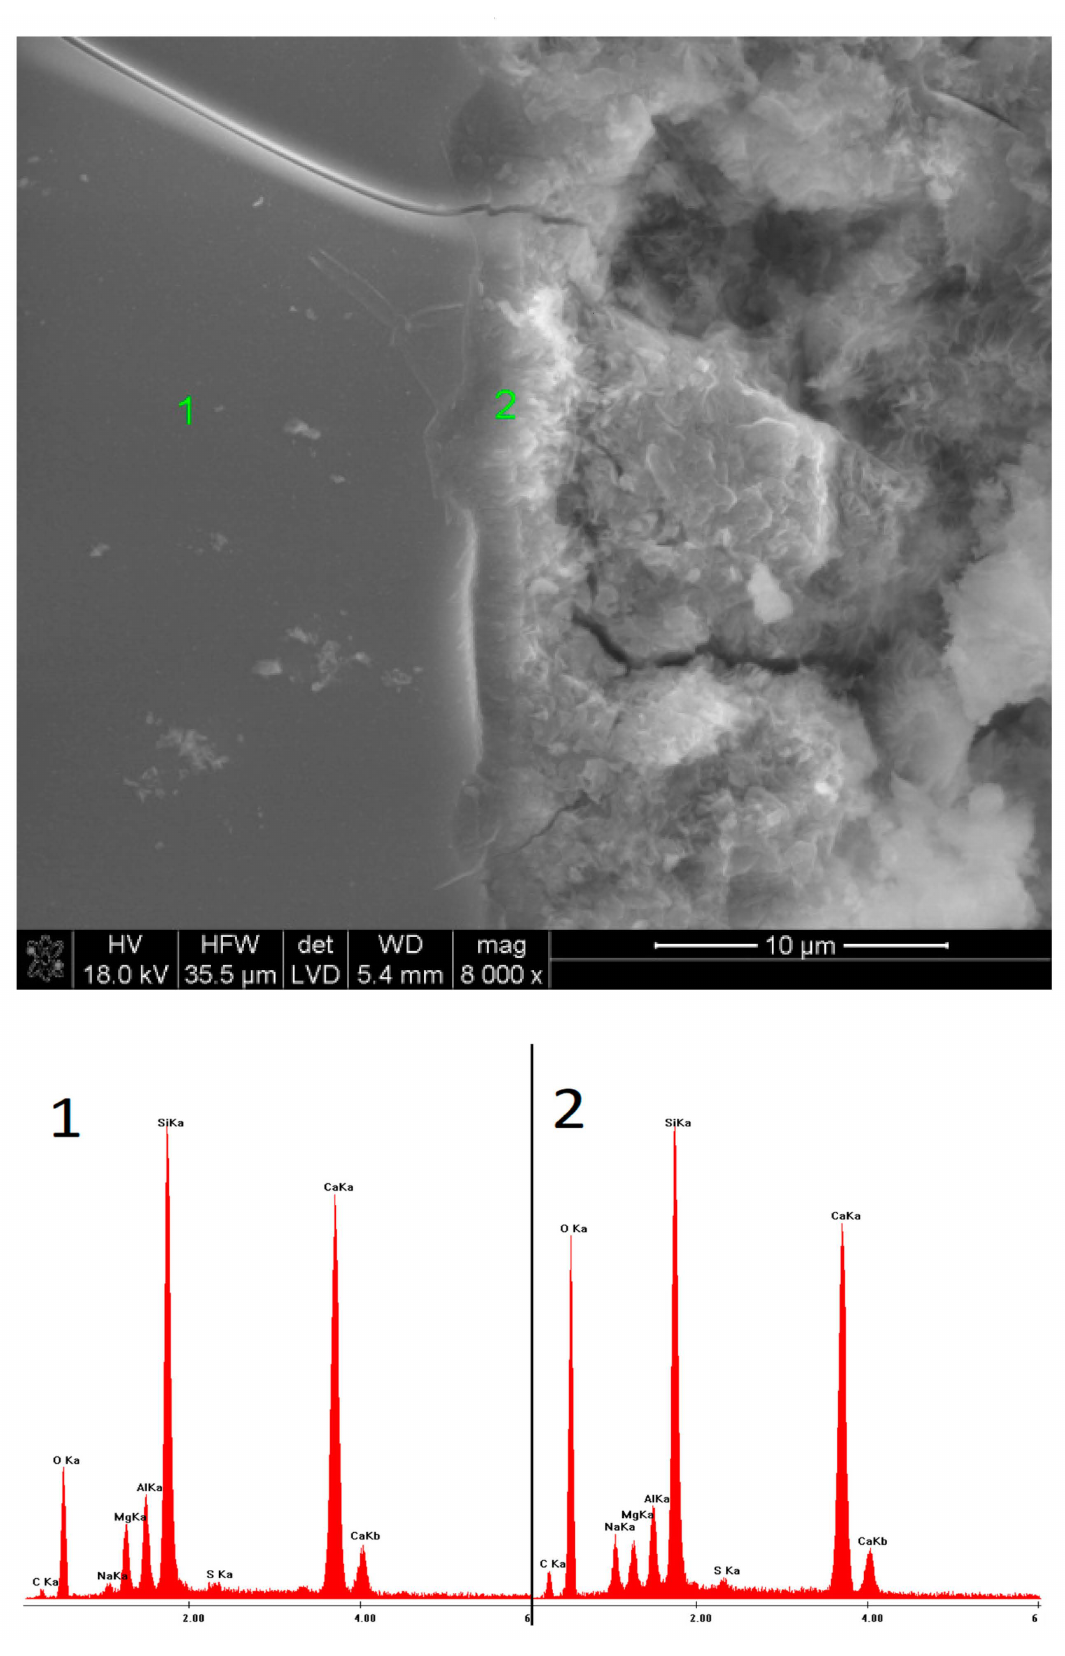
Figure 10. Microstructure of slag paste activated with sodium hydroxide after 360 days of curing—SEM + EDS; 1 —unreacted slag grain; 2 —hydration